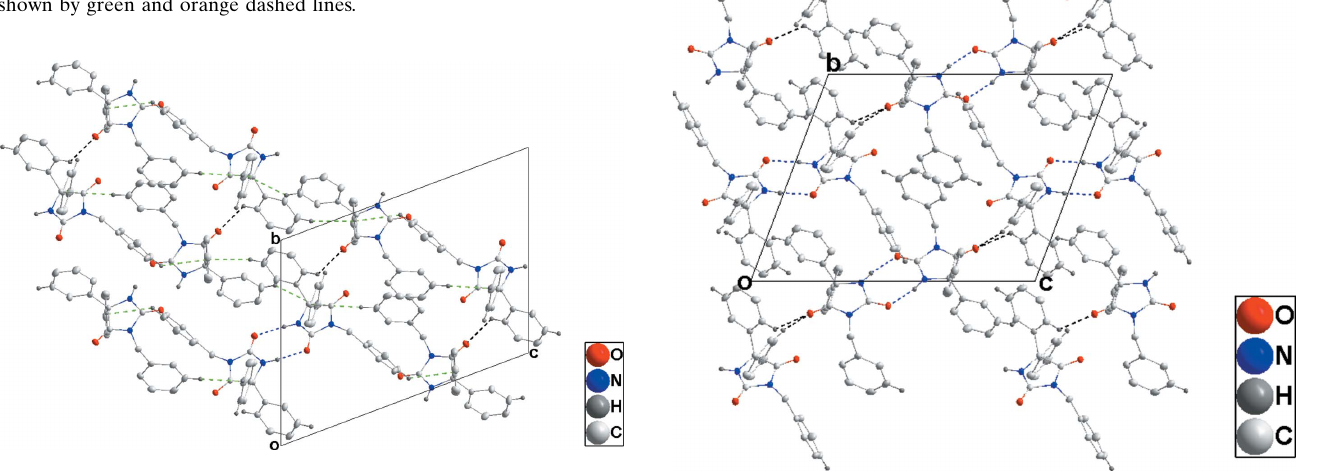
Figure 4 Packing viewed along the a -axis direction. Color codes are the same as in Fig. 2.